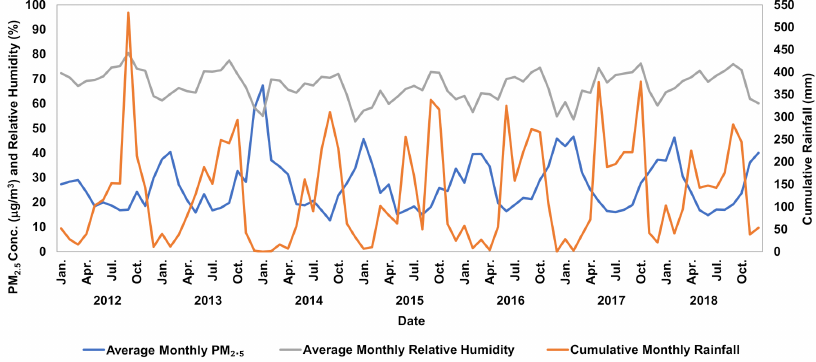
Figure 5. Monthly variation of PM 2.5 concentrations and relative humidity with cumulative monthly rainfall during